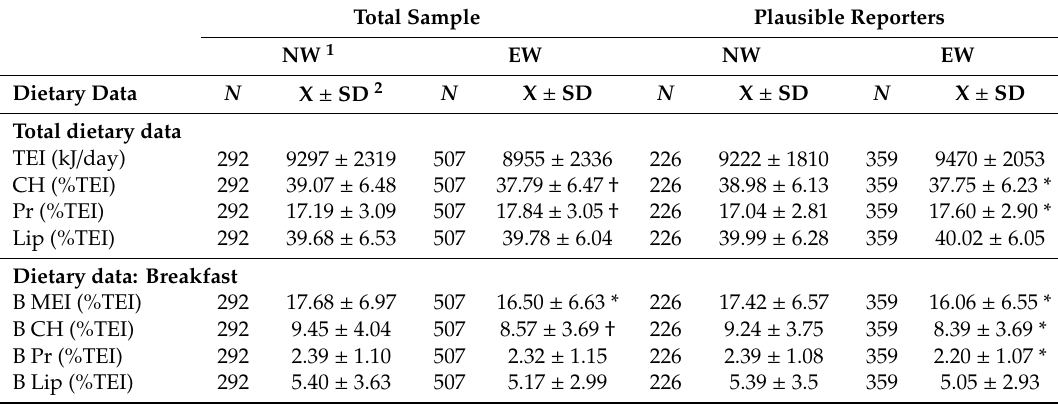
Table A3. Dietary data according to nutritional state (total sample and plausible